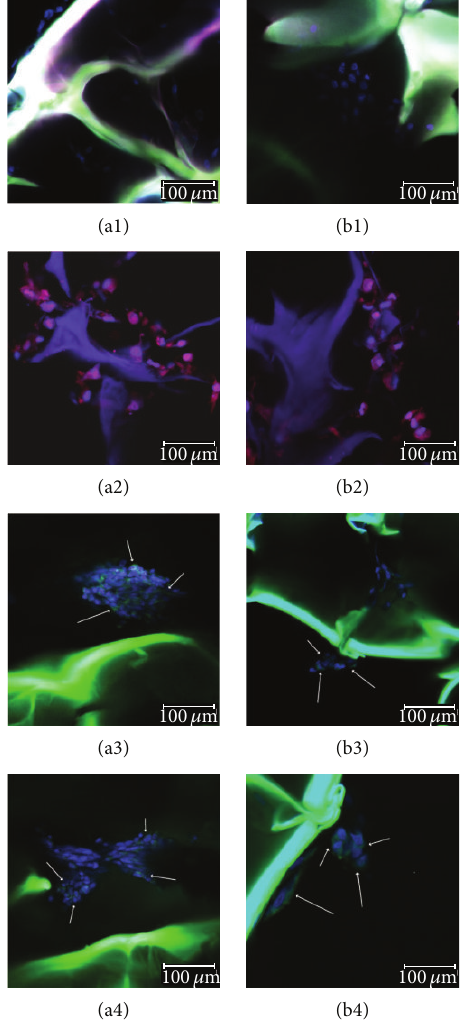
Figure 8: Confocal microscopy micrographs of cells inside (a) G-A-PAA and (b) G-A scaffolds during chondrogenesis: (1) 24 h after seeding, (2) Sox9 positive expression (red fluorescence) at 7 days postchondrogenic induction, (3) Col2a1 positive expression (green fluorescence) at 14 days postchondrogenic induction, and (4) CEP68 positive expression (green fluorescence) at 14 days postchondrogenic induction.